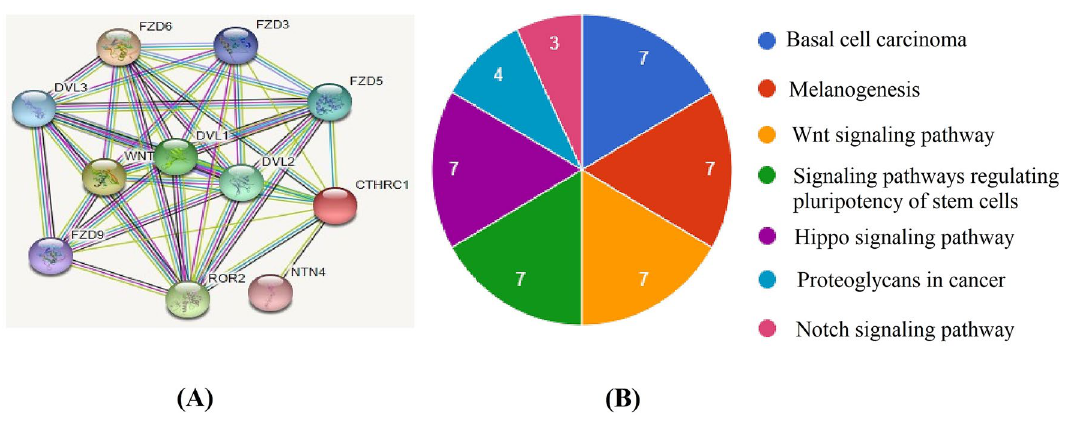
Figure 14. PPI network and Kyoto encyclopedia of genes and genomes (KEGG) pathway analysis of the CTHRC1 enriched genes. ( A ) A PPI network of CTHRC1 enriched genes, ( B ) KEGG pathway analysis of the CTHRC1 enriched